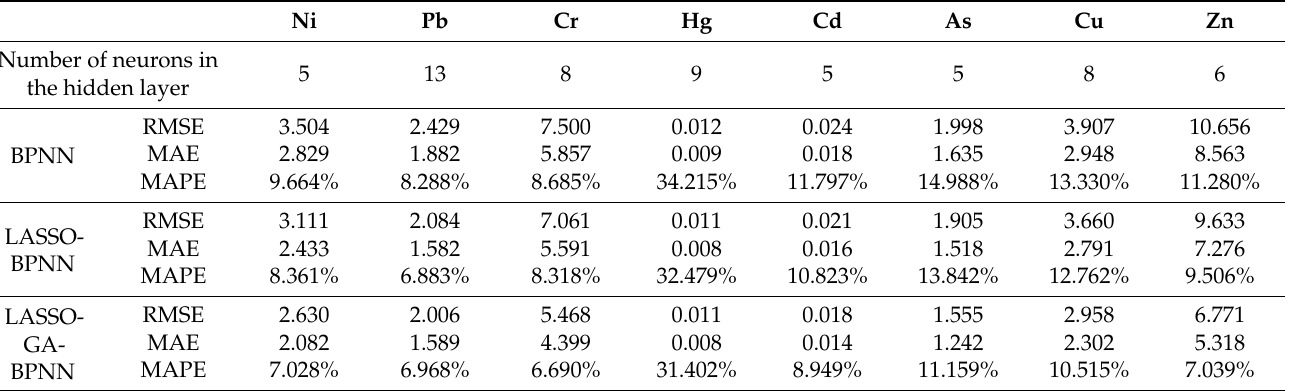
Table 3. GA optimization